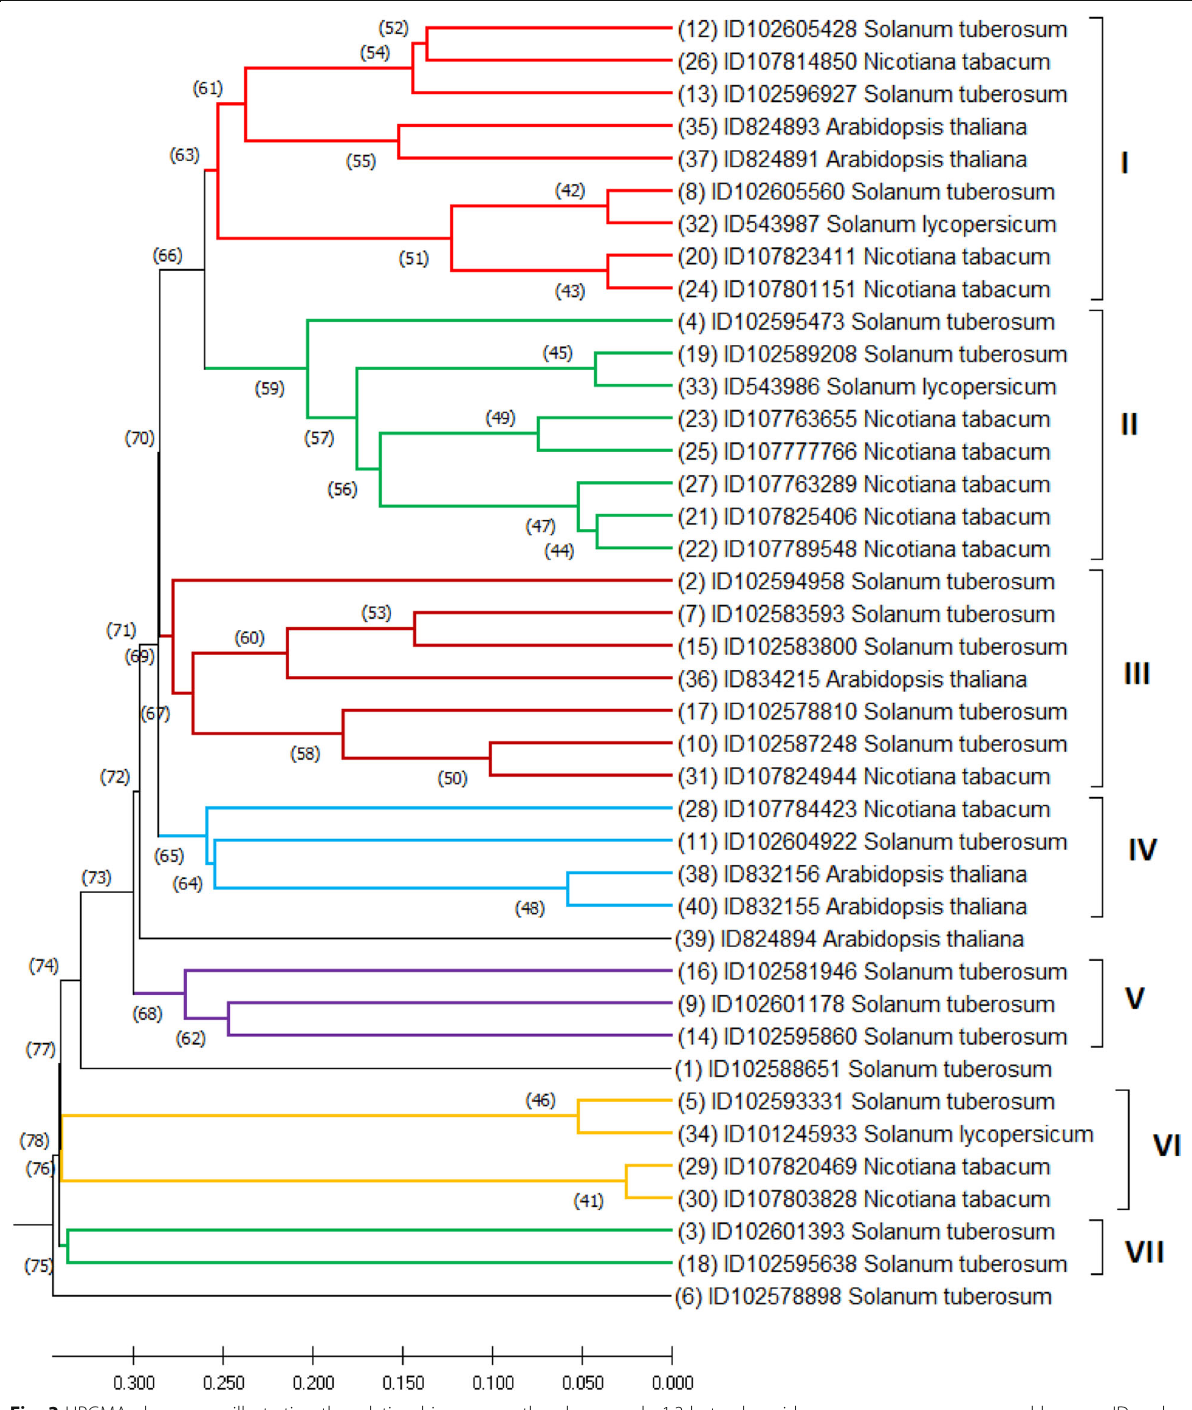
Though the percentage range of variable sites was wider than the conserved sites, the phylogeny showed the opposite relationship.